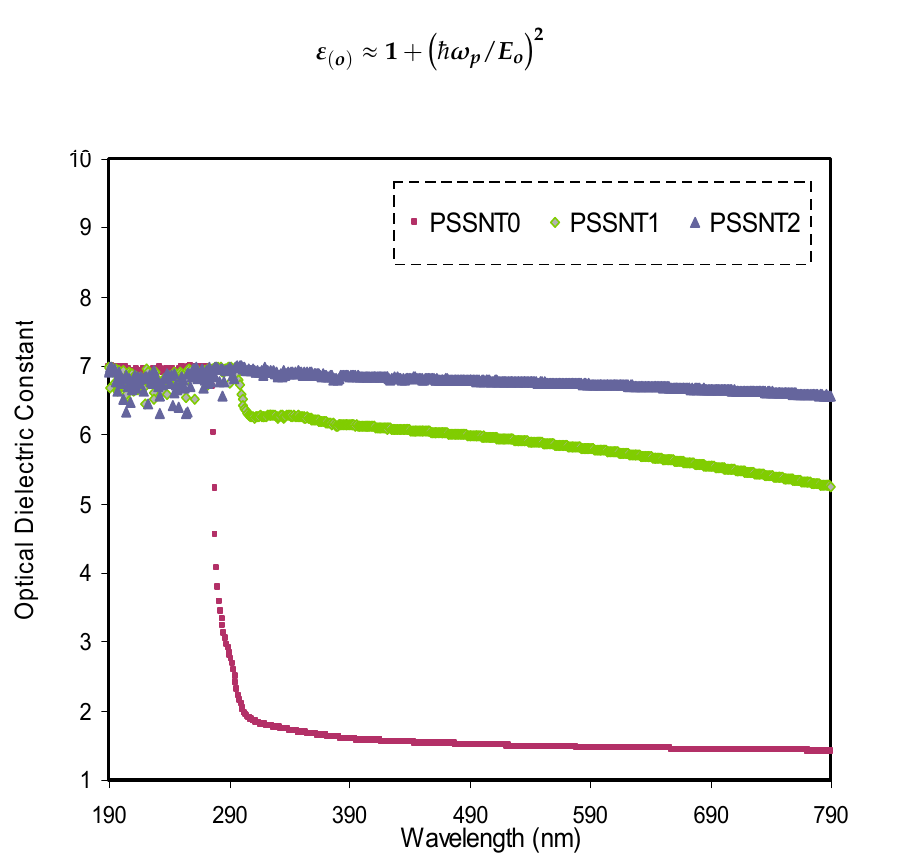
Figure 6. Dielectric constant spectra versus wavelength for pure PS (PSSNT0), PSSNT1, and PSSNT2 composite films.